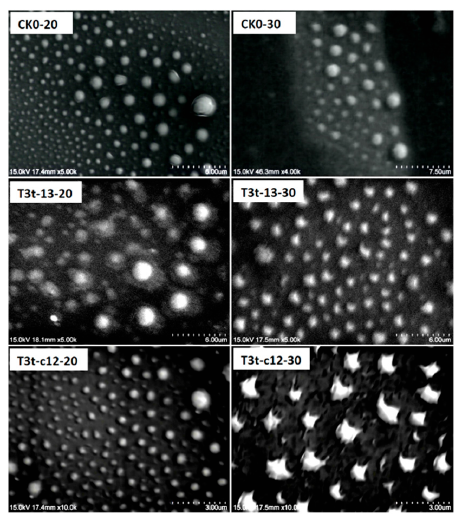
Figure 6. Morphology of dry particles from thermo-responsive AZO NPs under SEM. CK0-20 and CK0-30 were TDA-omitted AZO-loaded NPs desiccated at 20 °C and 30 °C, respectively; T3t-13-20 and T3t-c12-20 were NPs air-dried at 20 °C originating from T3t-13 and T3t-c12, respectively; T3t-13-30 and T3t-c12-30 were NPs air-dried at 30 °C originating from T3t-13 and T3t-c12, respectively.